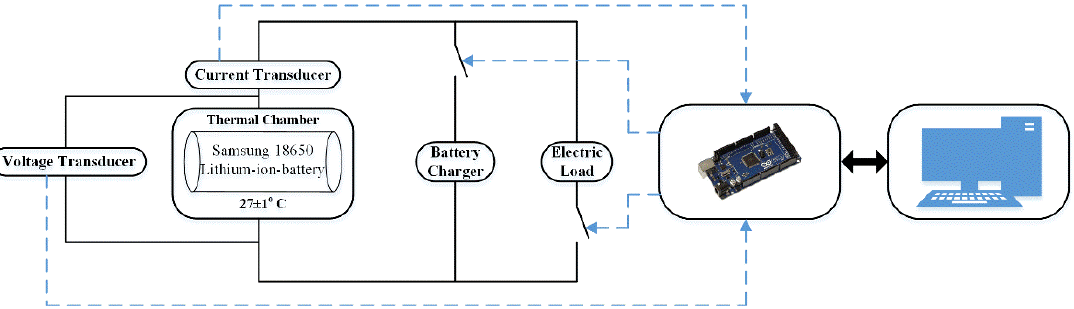
Figure 4. Experimental setup.